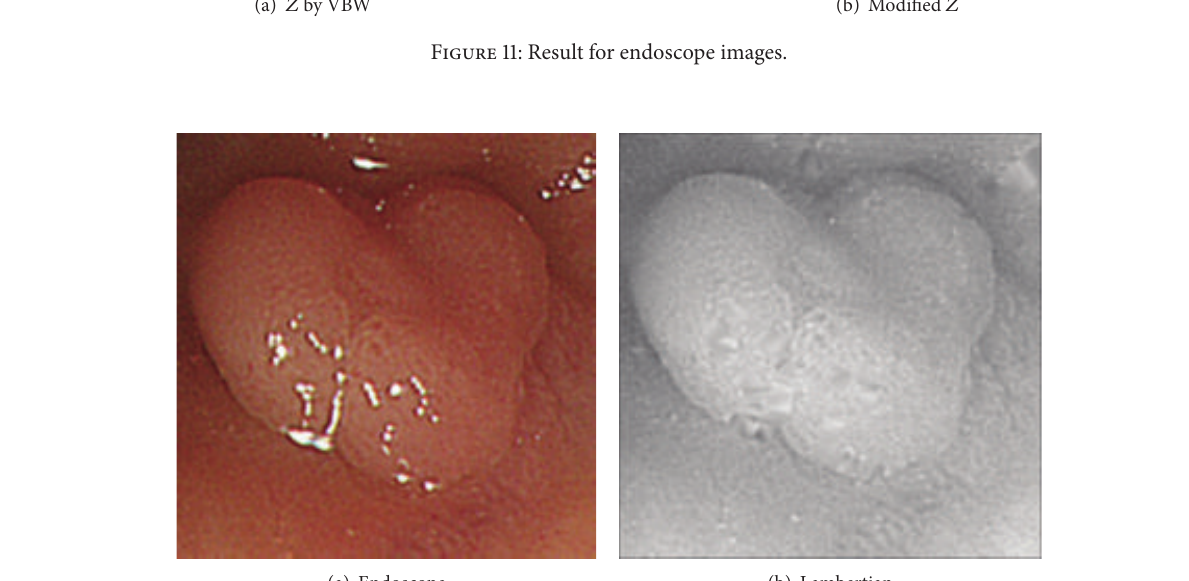
Figure 12: Endoscope image and generating Lambertian image.